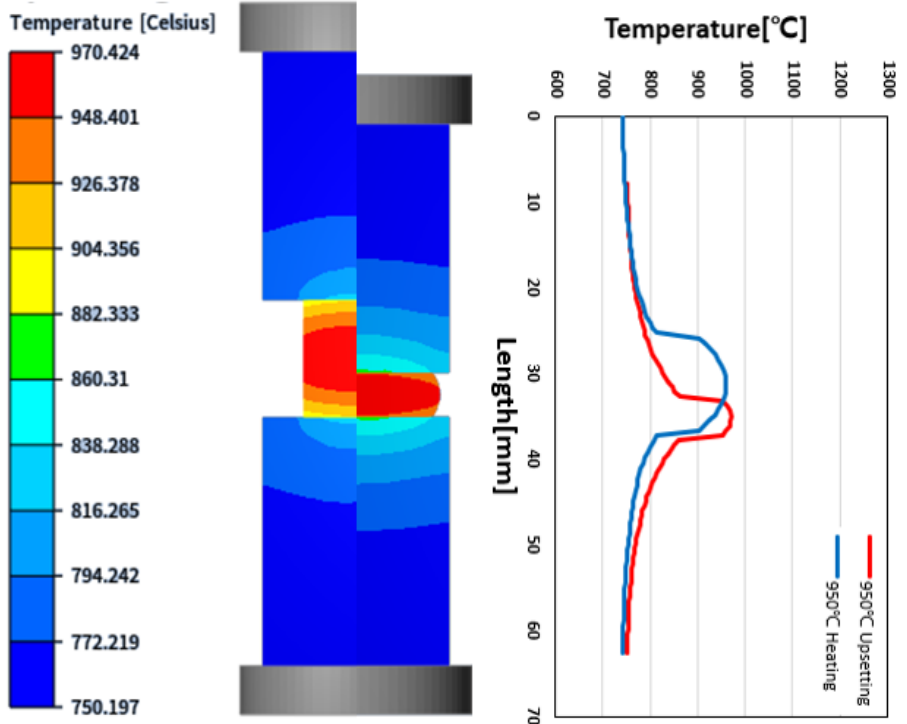
Figure 7. Temperature distributions determined by the finite element analysis of Joule heating and the upsetting processes.